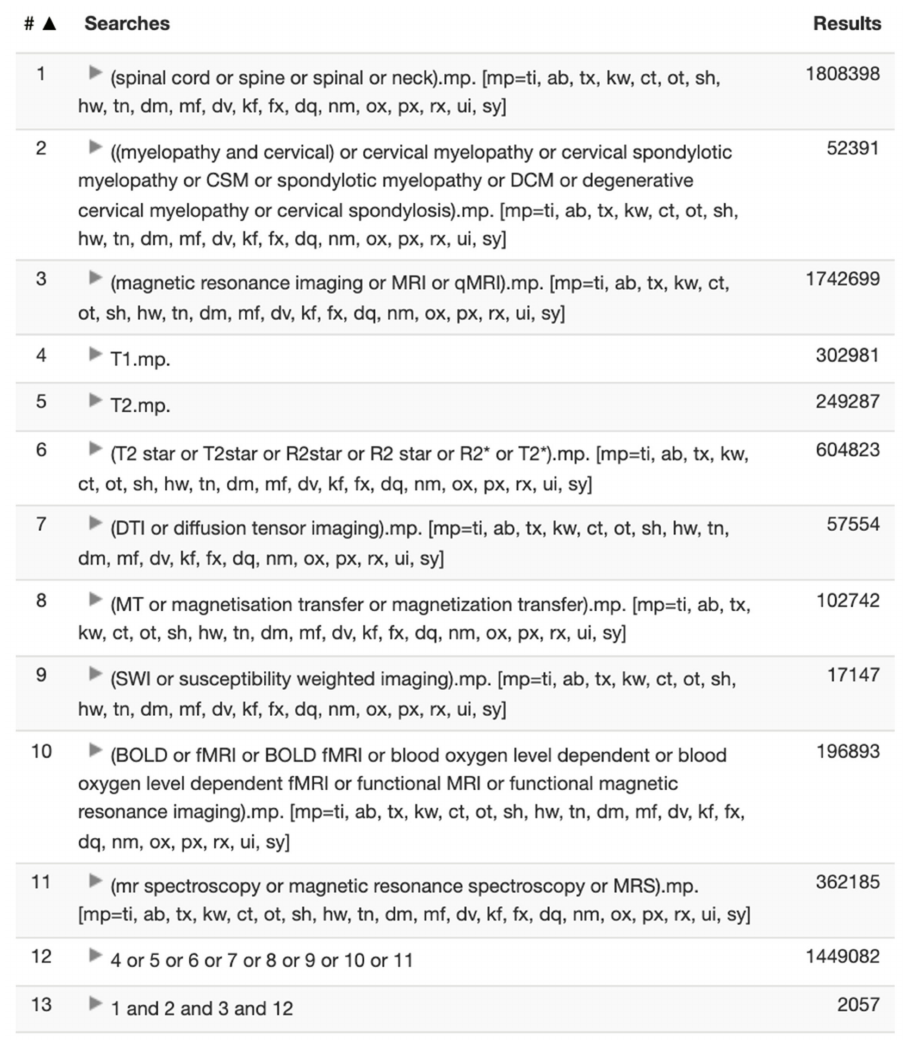
Figure A1. Database search